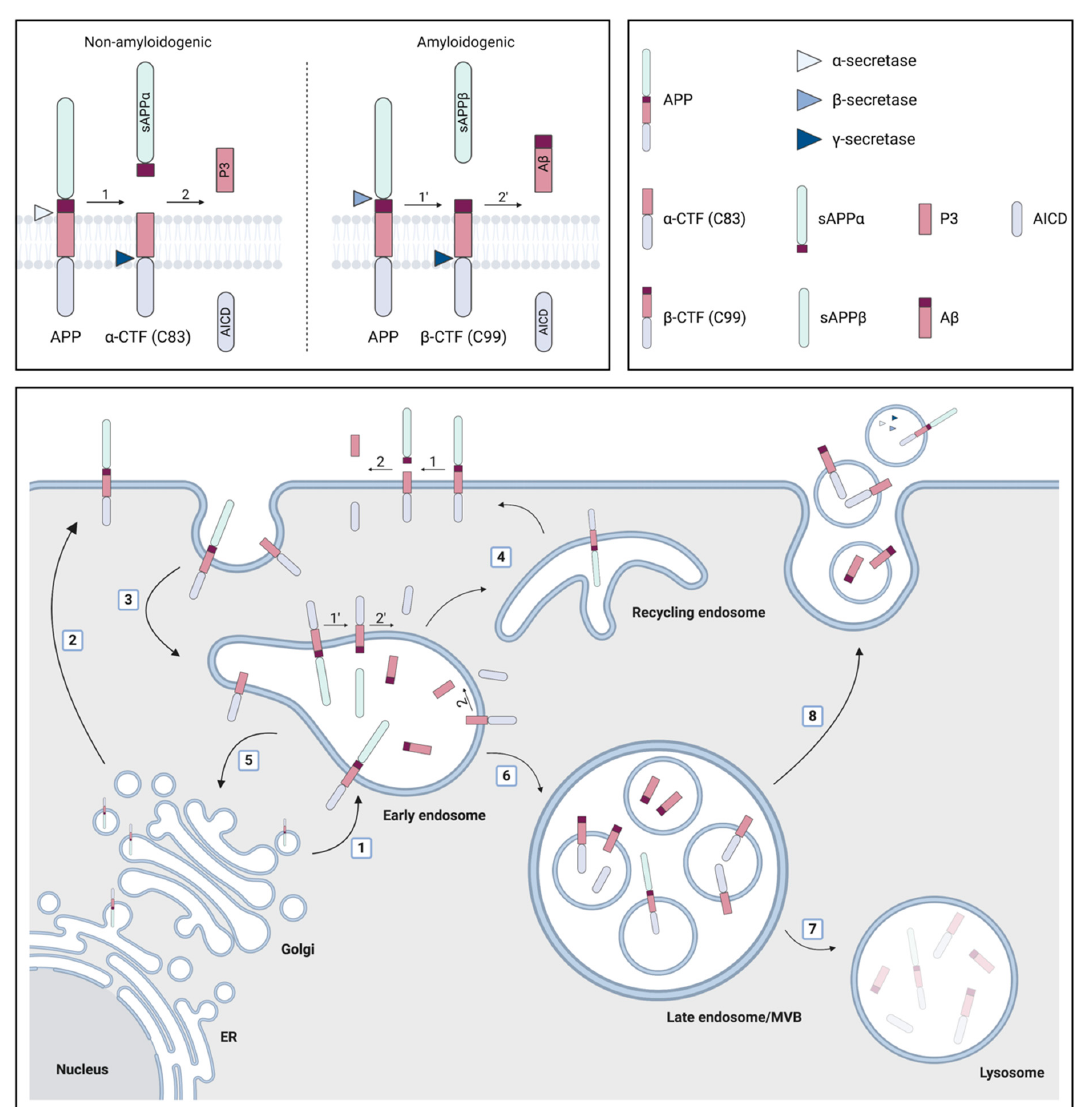
Figure 1. The role of multivesicular bodies (MVBs) and extracellular vesicles (EVs) in amyloid precursor protein (APP) processing. APP is synthesized in the endoplasmic reticulum (ER) and subsequently transported through the Golgi compartment to early endosomes (1) or the plasma membrane (2), where it can be cleaved by α -secretase in the non-amyloidogenic pathway. This cleavage leads to the formation of soluble APP α (sAPP α ) and the α -C-terminal fragment ( α -CTF or C83). Alternatively, APP can be re-internalized in endosomes (3) where the amyloidogenic cleavage by β -secretase preferentially occurs. Thereby, sAPP β and β -CTF (C99) are generated. The formation of the APP intracellular domain (AICD) and either the P3 fragment or the amyloid β (A β ) peptide from α - and β -CTF, respectively, requires cleavage by the γ -secretase complex. Early endosomes recycle to the plasma membrane (4), undergo retrograde transport to the trans-Golgi network (5) or mature into late endosomes/MVBs (6). The latter either fuse with lysosomes (7) or with the plasma membrane (8), resulting in the extracellular release of their intraluminal vesicles (ILVs) as EVs. Several products of the APP processing pathway have been localized to MVBs (i.e., APP itself; α - and β - CTF; AICD; A β ) and EVs (i.e., APP itself; α - and β - CTF; A β ; α -, β - and components of the γ -secretase complex), whereby A β can be localized both on the inside and on the surface of EVs. Figure created with